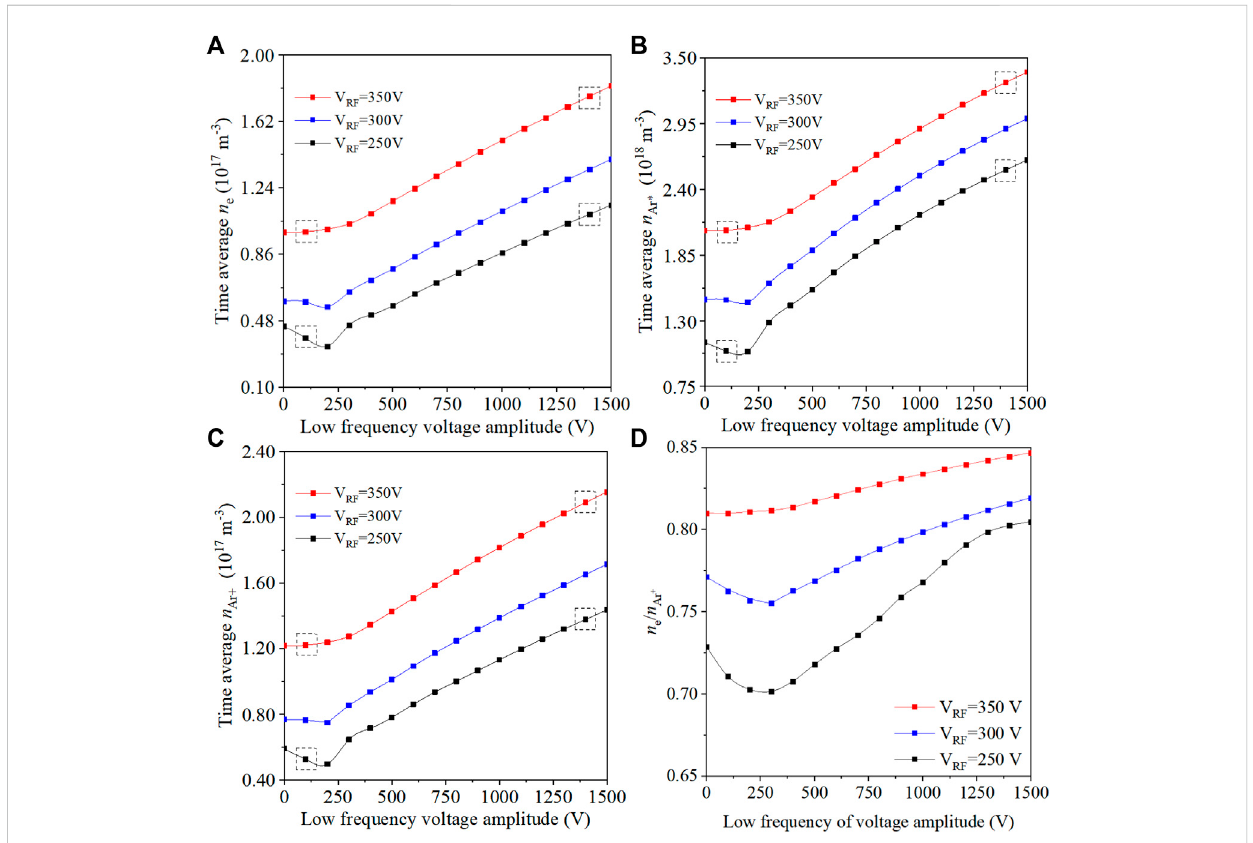
FIGURE 5 Time-averagedparticledensitiesvariedwiththelowfrequencyvoltagefor (A) theelectron, (B) theAr*,and (C) theAr+,at V RF =250,300,and350 V, respectively, and (D) the ratio of the maximal density electrons and Ar